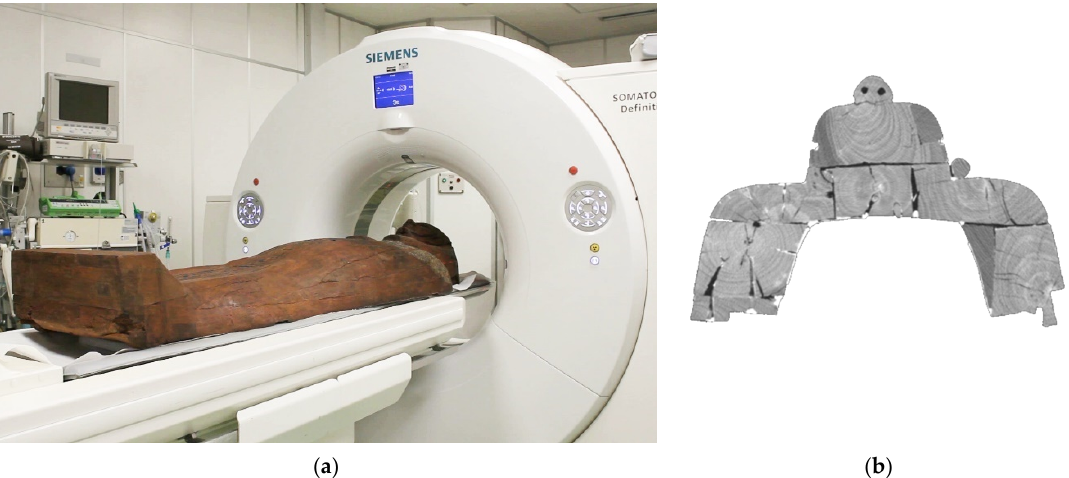
Figure 2. Three-dimensional exploration of the Pef’s coffin interiors with X-Rays: ( a ) the computer tomography (CT) scanning of the coffin at the Galeazzi Hospital in Milan (Italy); ( b ) the section of the wooden coffin that allows to see the inner structure.